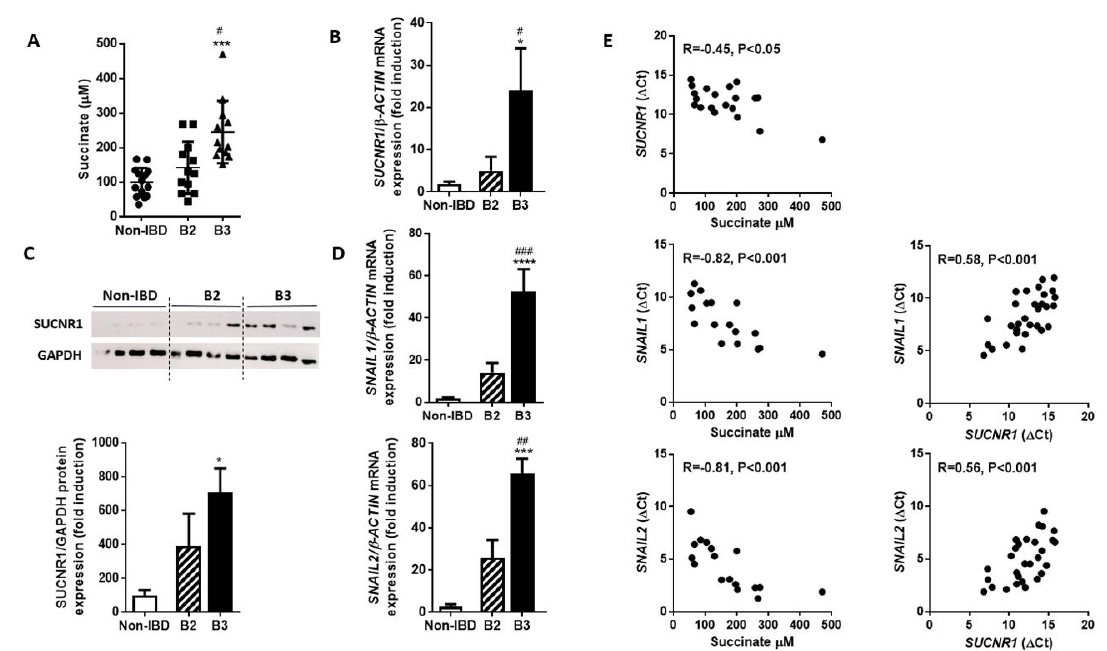
Figure 2. Intestinal succinate levels and SUCNR1 expression is increased in B3 CD-patients. Graphs show succinate levels ( A ), SUCNR1 mRNA ( B ) and protein ( C ) expression, and the mRNA expression of SNAIL1 and SNAIL2 ( D ) in intestinal resections from non-Inflammatory Bowel Disease (non-IBD), B2 and B3 Crohn’s disease patients. In all cases, bars in graphs represent mean ± SEM, and significant differences vs. the non-IBD group are shown by * p < 0.05, *** p < 0.001 or **** p < 0.0001 and vs. B2 Crohn’s disease patients are shown by # p < 0.05, ## p < 0.01 or ### p < 0.001. ( E ) Correlation between data relative to the mRNA expression of SUCNR1, SNAIL1, and SNAIL2 (expressed as delta Ct) and the levels of succinate on intestinal samples. A positive and significant correlation was detected between succinate levels and the expression of SUCNR1, SNAIL1 and SNAIL2 as well as between the expression of SUCNR1 and that of SNAIL1 and SNAIL2 , (R = Spearman’s correlation coefficient).